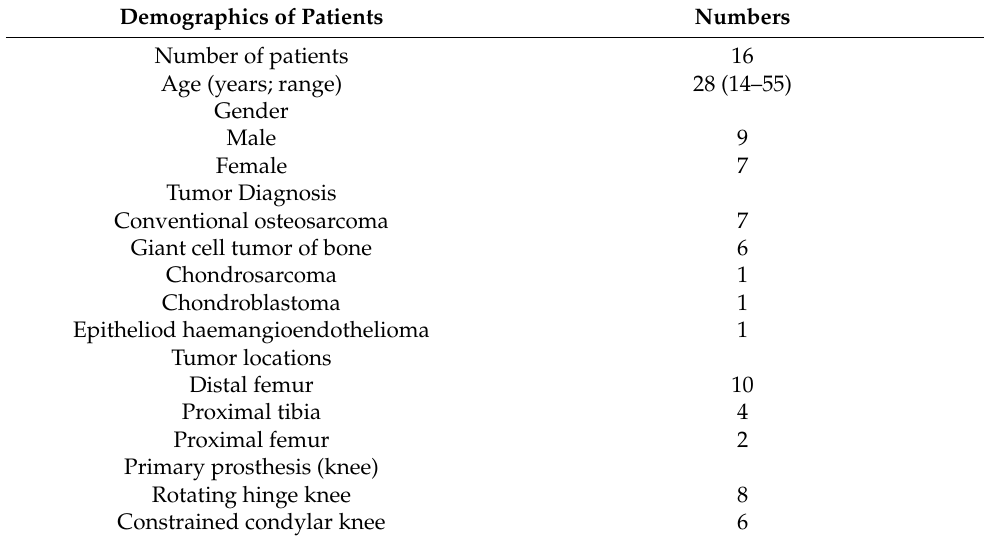
Table 1. Patients